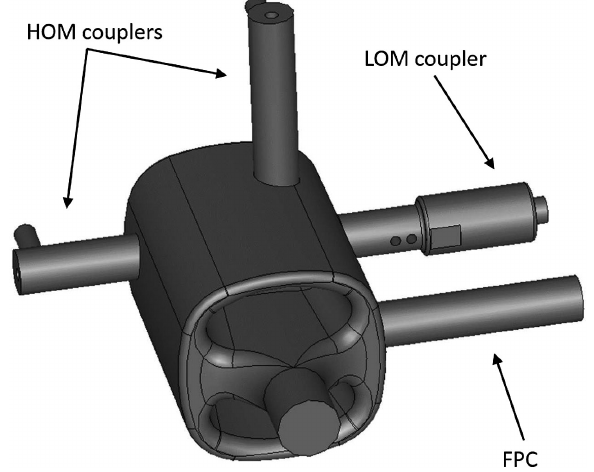
FIG. 27. A CAD drawing of the 4RCC with the HOM and LOM couplers as well as the fundamental power coupler (FPC).